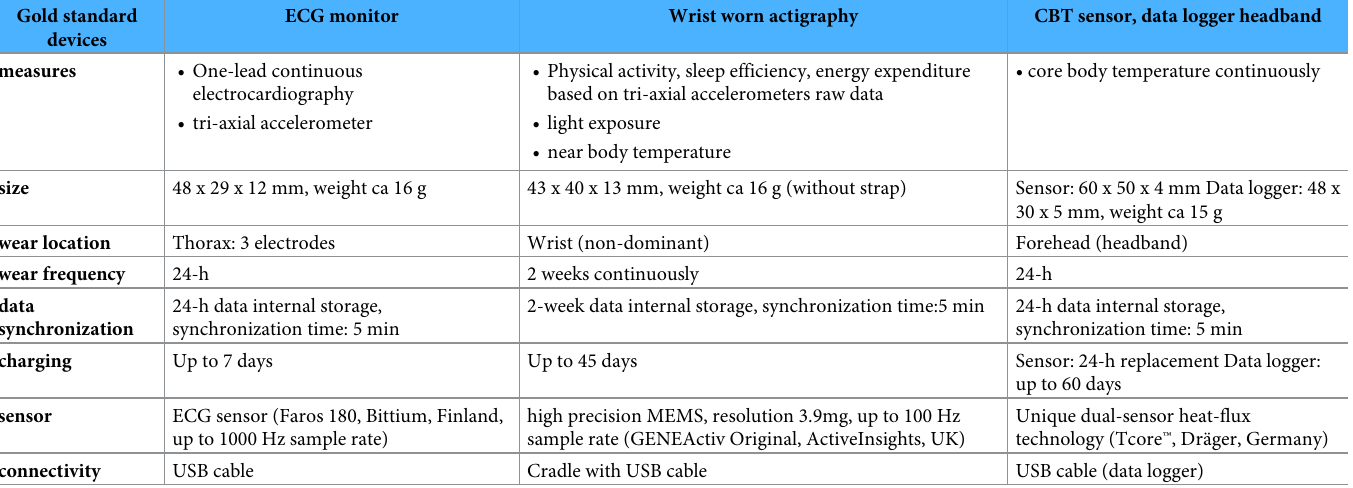
Table 2. Overview of gold standard wearable